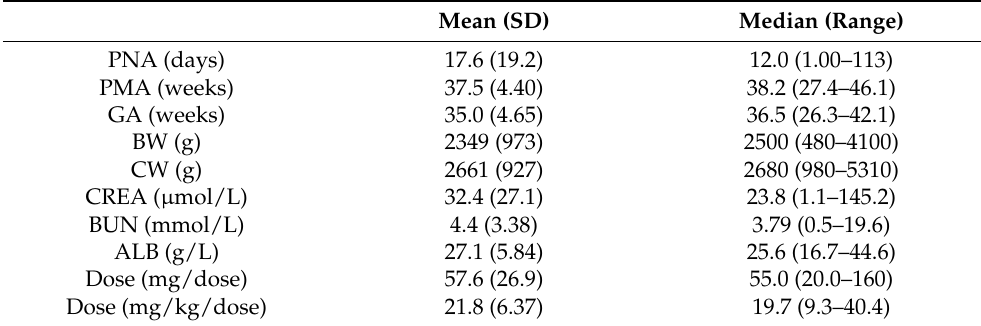
Table 1. Characteristics of 78